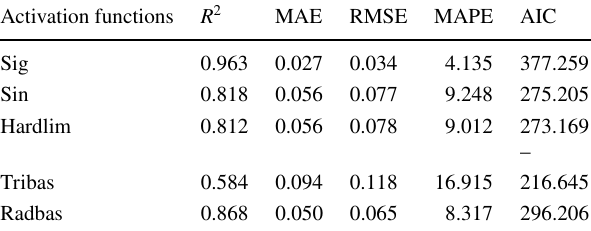
Table 1 Results of statistical indices for different activation